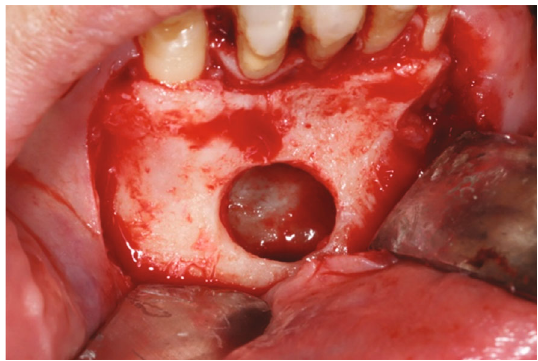
Figure 6: Removal of the lesion through the bone hatch.